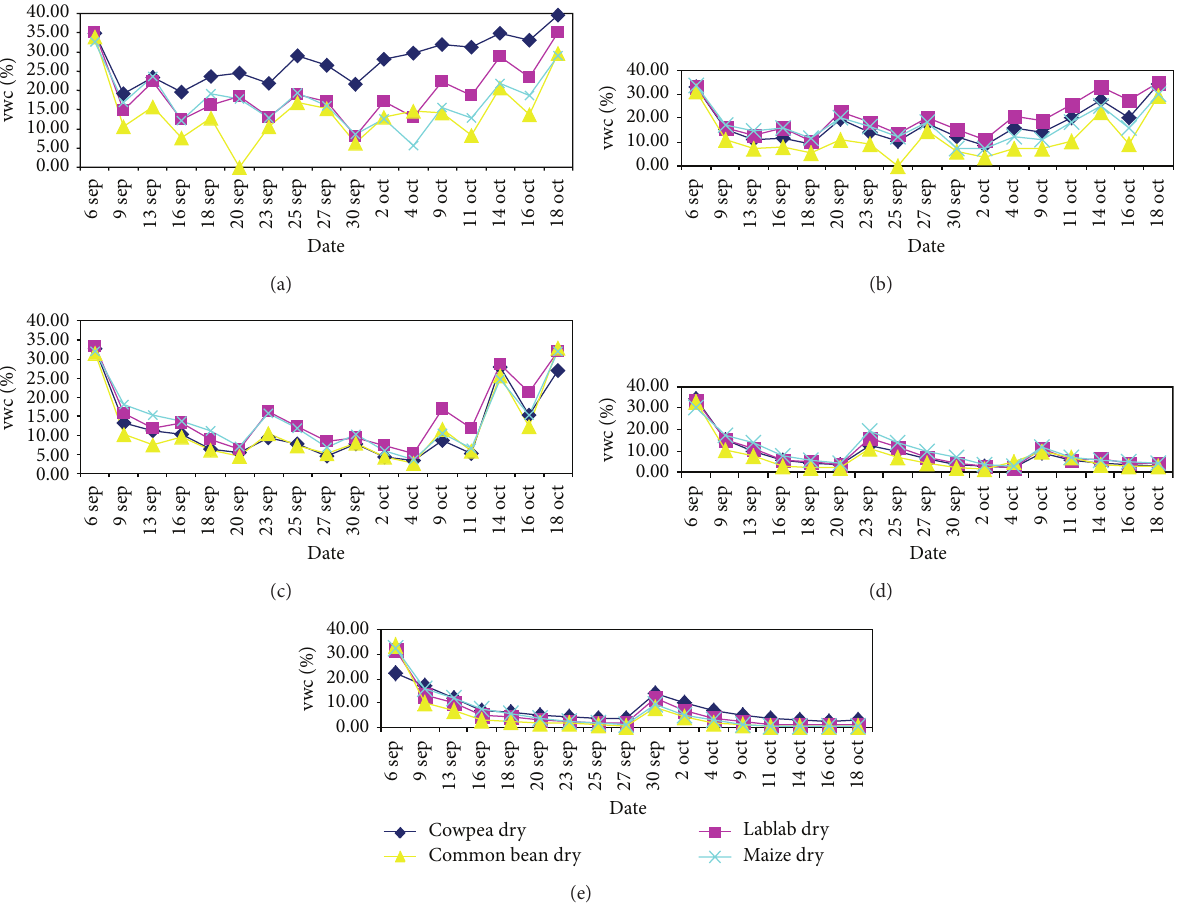
Figure 7: Soil moisture content of different water level: (a) fully watered (b) partially watered (c) moderately watered, (d) near to dry, and (e)